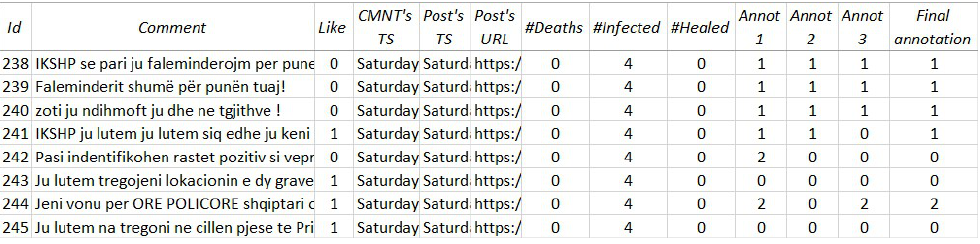
Figure 3. Final dataset.